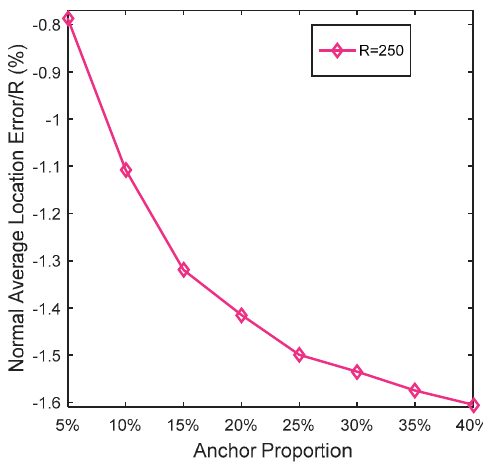
Figure 20. The influence of anchor WSN#2.